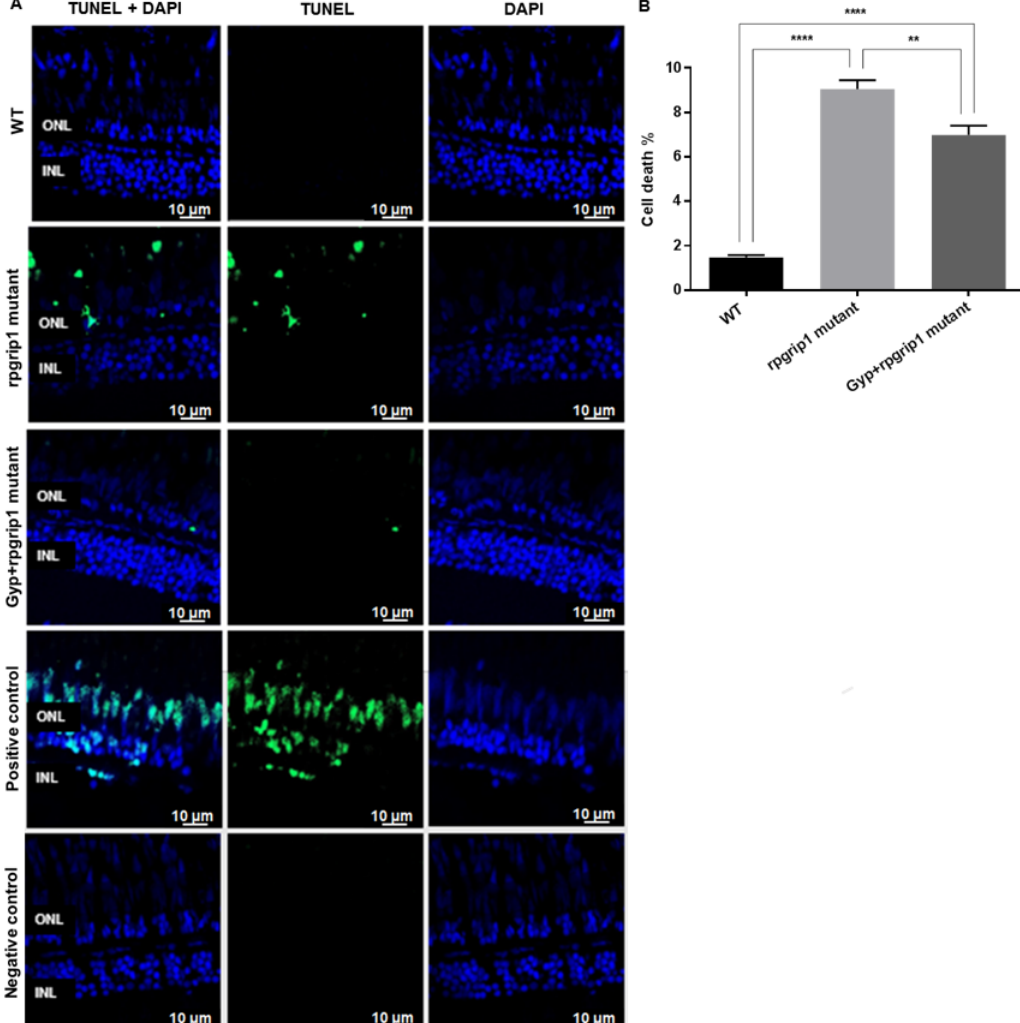
Figure 3. Significant decreases were found in cone apoptosis in rpgrip1 mutant zebrafish treated with Gyp. ( A ) Retinal sections of wildtype (WT), untreated (UT) rpgrip1 mutant and Gyp-treated rpgrip1 mutant zebrafish at 6 mpf were stained with TUNEL reagents. Nuclei of apoptotic cone cells were stained in green. DAPI labelled nuclei were stained in blue. ( B ) Quantification of apoptotic cells in above retinal sections were compared between the wildtype, rpgrip1 mutant and Gyp-treated rpgrip1 mutant zebrafish. Statistical comparisons between individual groups were carried out using one-way ANOVA followed by Bonferroni’s test. Data are displayed as mean ± SEM ( n = 6 animals of each group). ** p < 0.01, **** p < 0.0001. INL, inner nuclear layer; ONL, outer nuclear